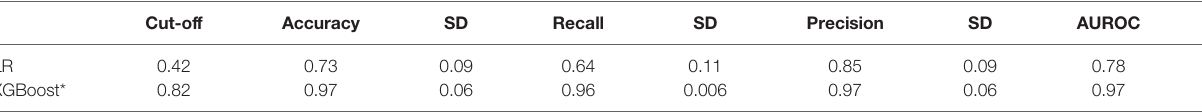
TABLE 3 | Algorithm performance. Cut-off